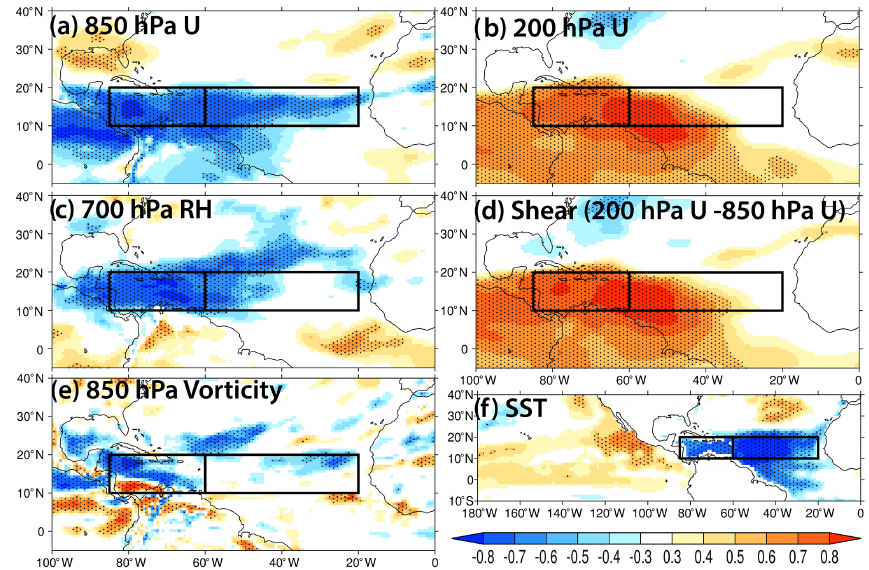
Figure 8. Correlation between MRC JJA regionally averaged DAOD in the Caribbean and JJA (a) 850hPa U , (b) 200hPa U , (c) 700hPa RH, (d) zonal wind shear, (e) 850hPa relative vorticity, and (f) SST. Correlations over the black dotted areas are statistically significant.